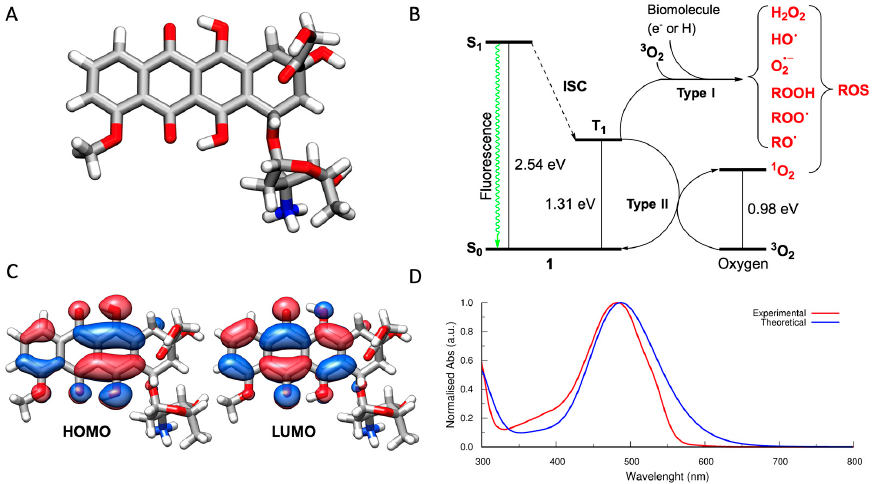
Figure 2. ( A ) A 3D representation of the most stable tautomer of the doxorubicin molecule. ( B ) Jablonski diagram of doxorubicin. ( C ) HOMO and LUMO of doxorubicin. ( D ) Experimental (red line) and calculated UV–Vis spectra of doxorubicin.